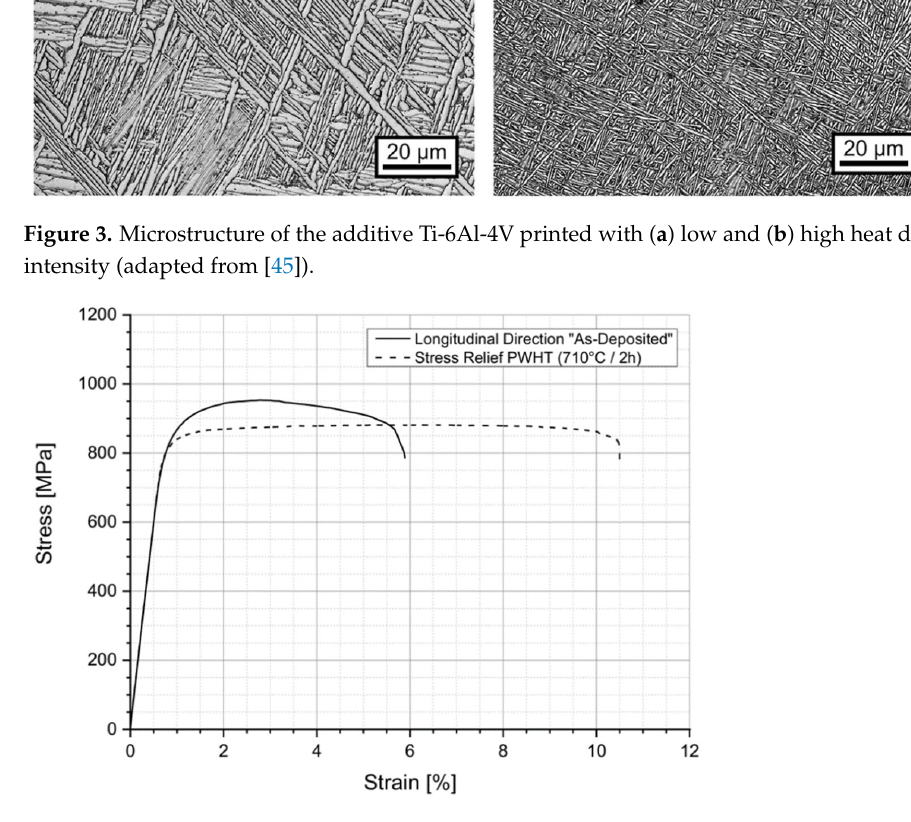
Figure 4. Stress–strain curves for AM Ti-6Al-4V samples in as-built state and after stress relief heat treatment (adapted from [43]).